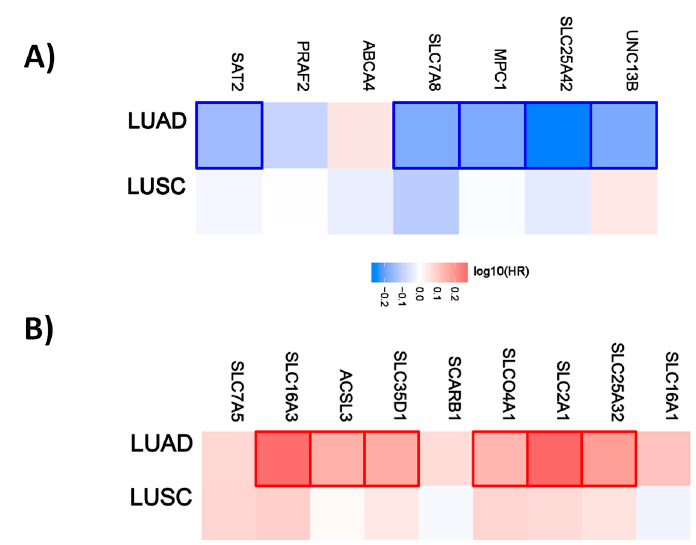
Figure 4. Hazard ratio of organic anion transporter expression in different lung cancer subtypes. The hazard ratio (HR) was calculated for ( A ) the favorable and ( B ) unfavorable list of genes in liver cancer for lung adenocarcinoma (LUAD) and lung squamous cell carcinoma (LUSC). The red and blue colors denote higher and lower risk, respectively. The rectangles with frames represent the statistically significant HR ( p < 0.05).